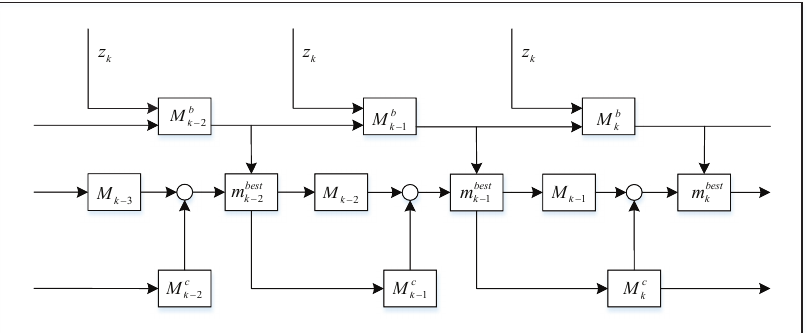
Figure 3. Recursive flow of model set changes in AG-BMA